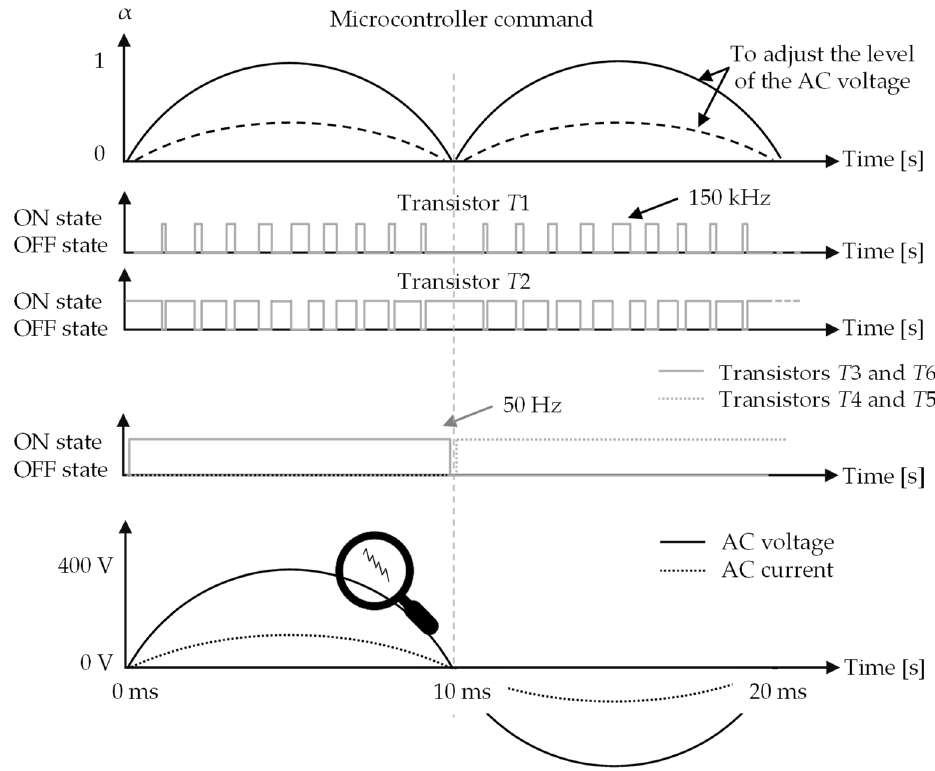
Figure 6. Control strategy of the MOSFETs inside the proposed bidirectional DC–AC converter used in inverter mode.